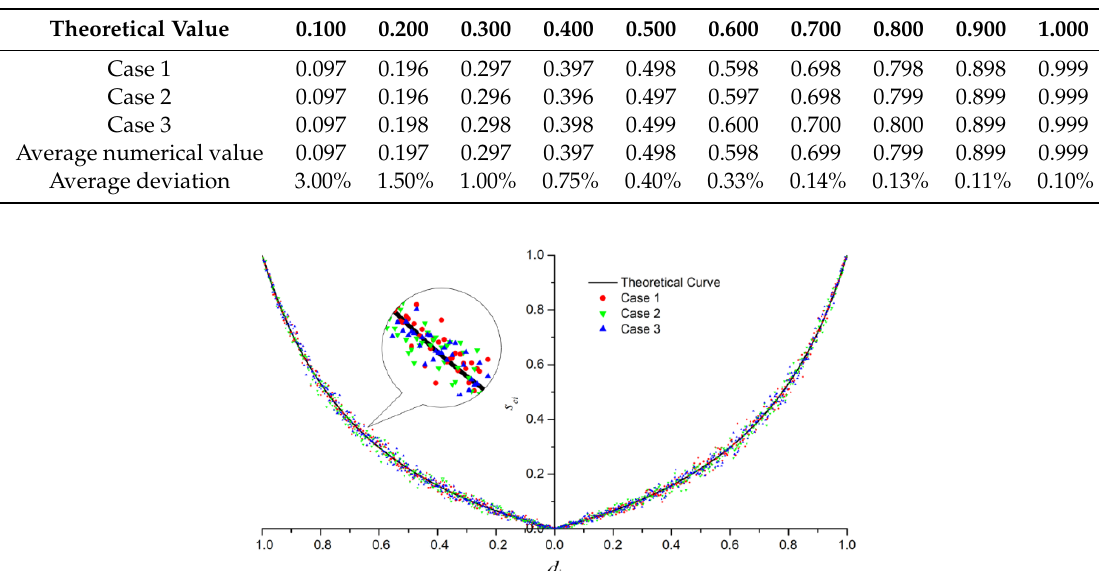
Table 1. Saturation coefficients obtained in the particle flow code (PFC) model.